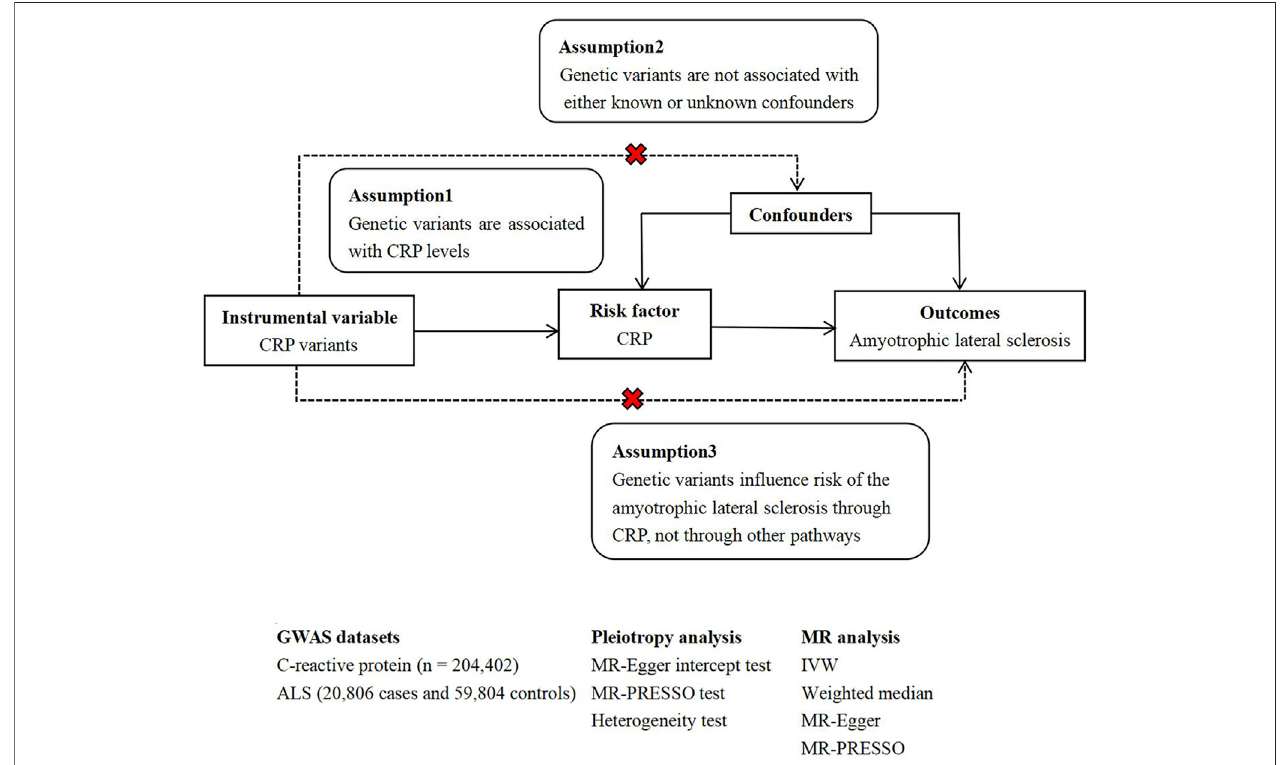
FIGURE 1 | The fl ow chart of the MR study